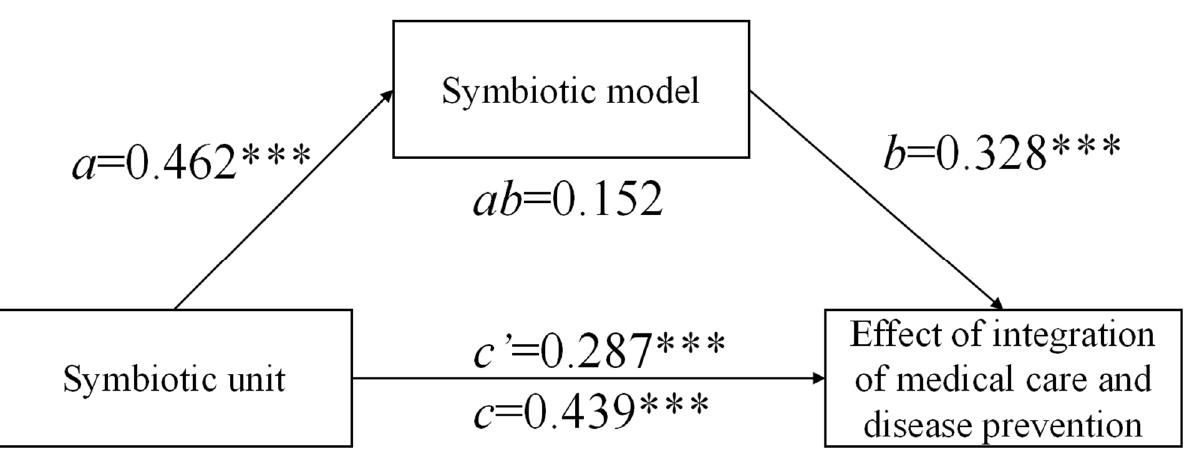
Figure 3. Mediating effects of symbiotic unit, model, and effect. Note: *** significant levels of 0.1%.